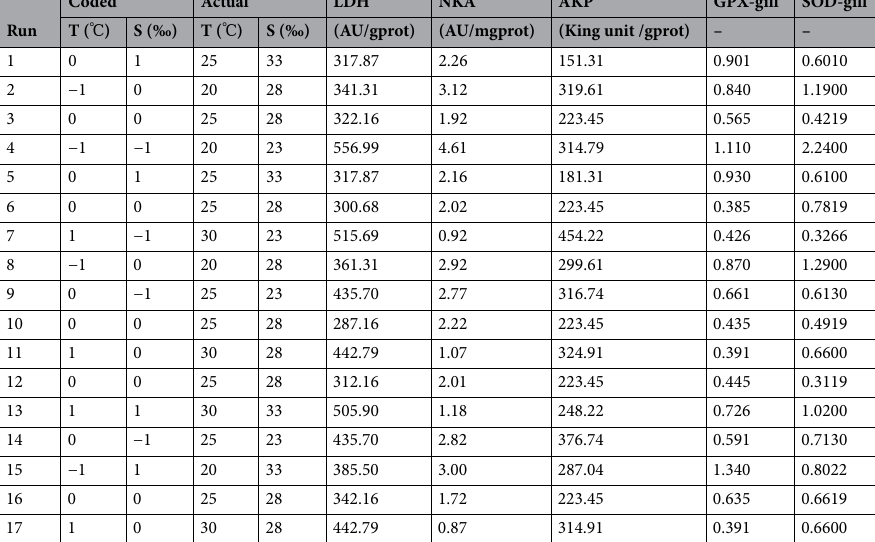
Table 7. Experimental design and results of respiratory metabolic response